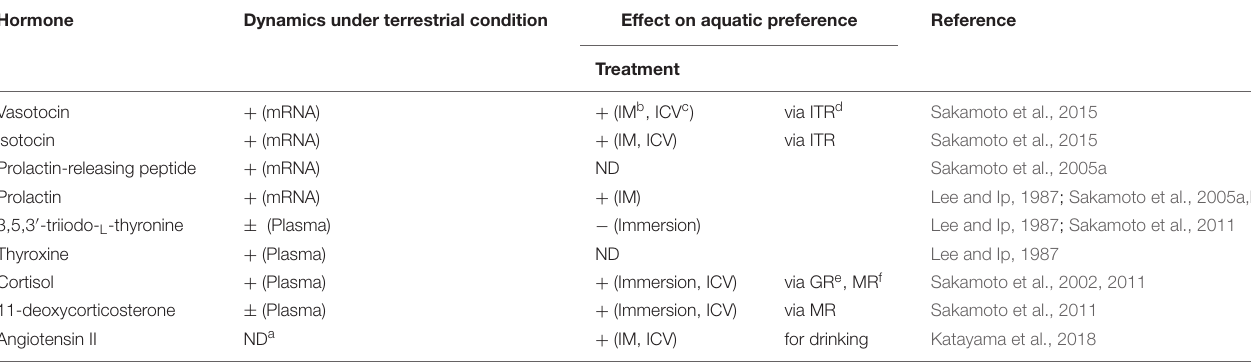
TABLE 1 | Hormones involved in the amphibious habits of